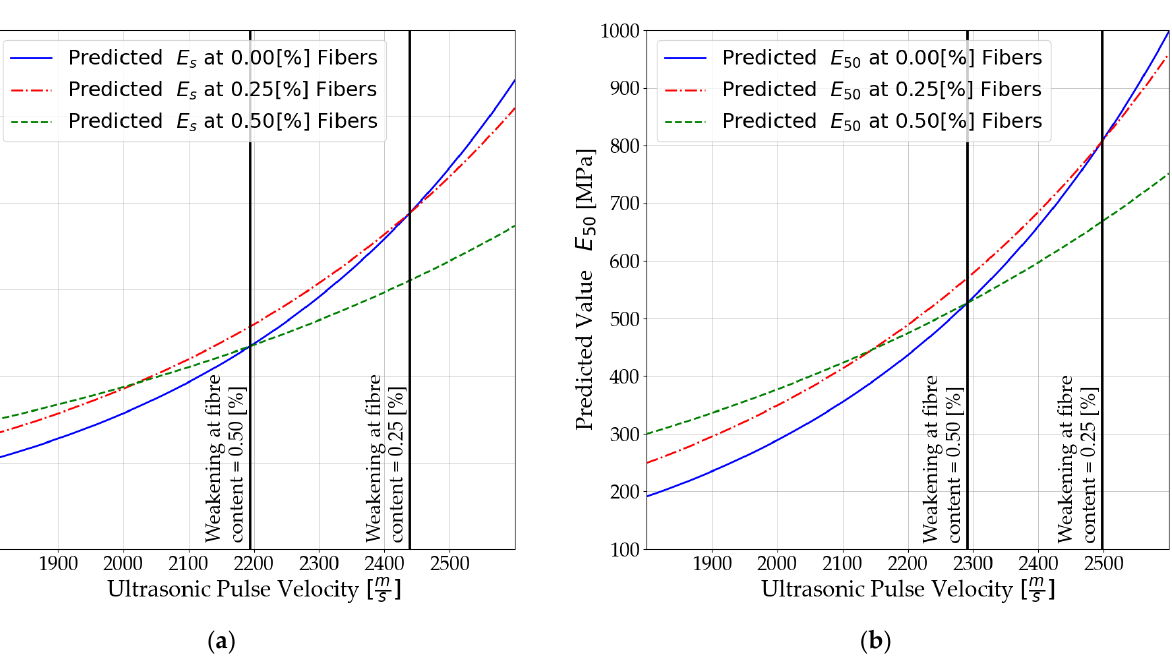
Three curves were obtained based on the analysis. The limiting velocities of ultrasonic